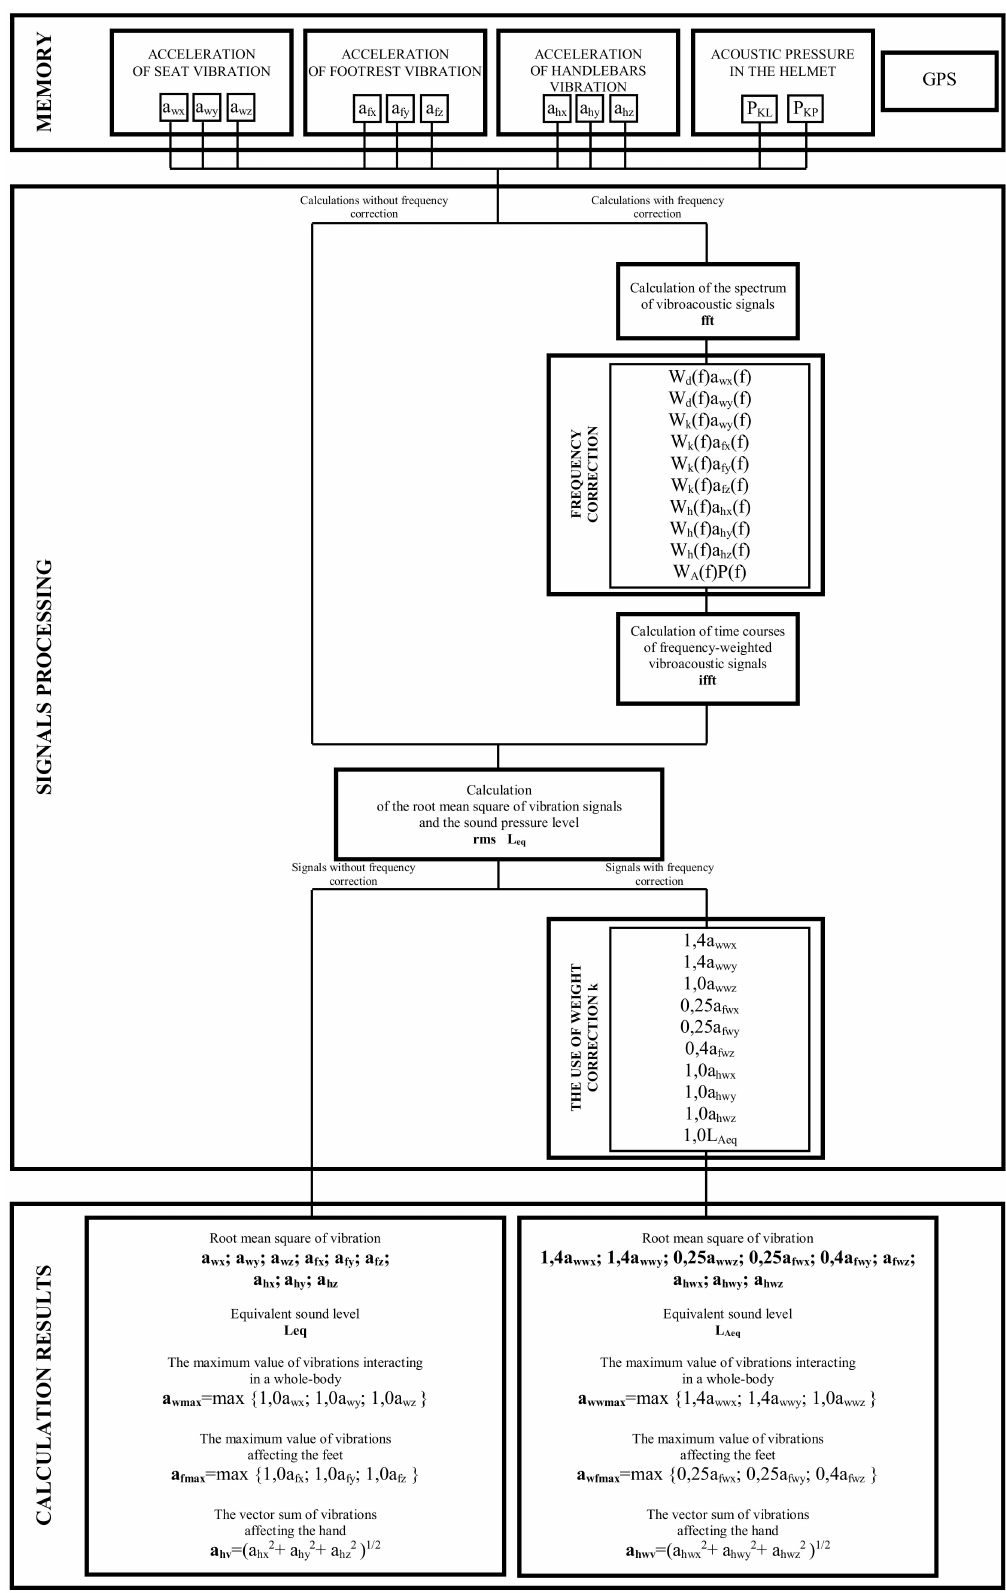
Figure 6. Method of determining signals for